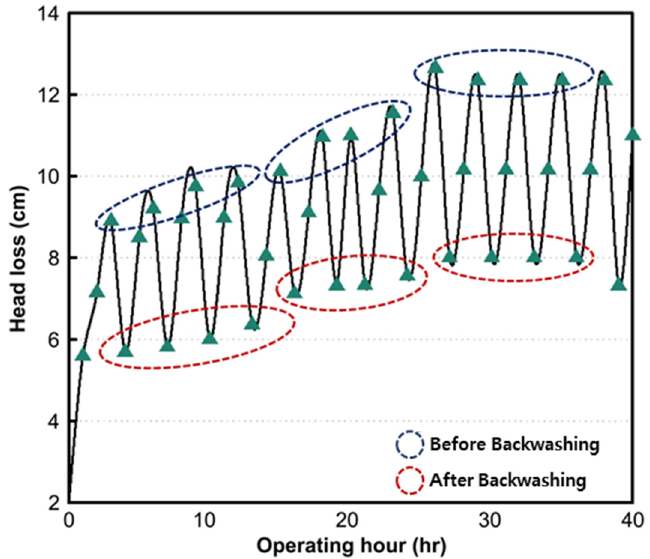
Table 4. Particle size distribution of each process.